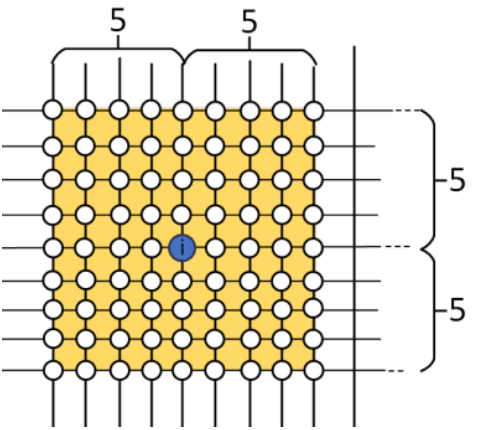
Figure 2. Illustration of the region containing pixel 𝑖 . All windows 𝑤 with size 5 × 5 that have i must be within the yellow part. Therefore, under the influence of the local window 𝑤 , there are at most 80 pixels around pixel 𝑖 . If the image has 𝑁 pixels, the total number of nonzero elements in matrix 𝐷 is less than 80 × 𝑁 .